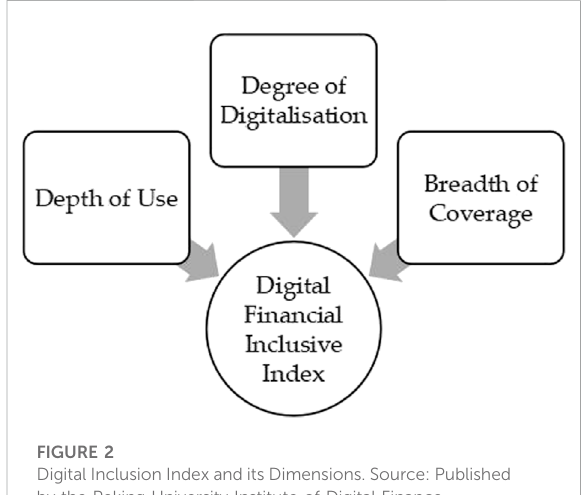
FIGURE 2 Digital Inclusion Index and its Dimensions. Source: Published by the Peking University Institute of Digital